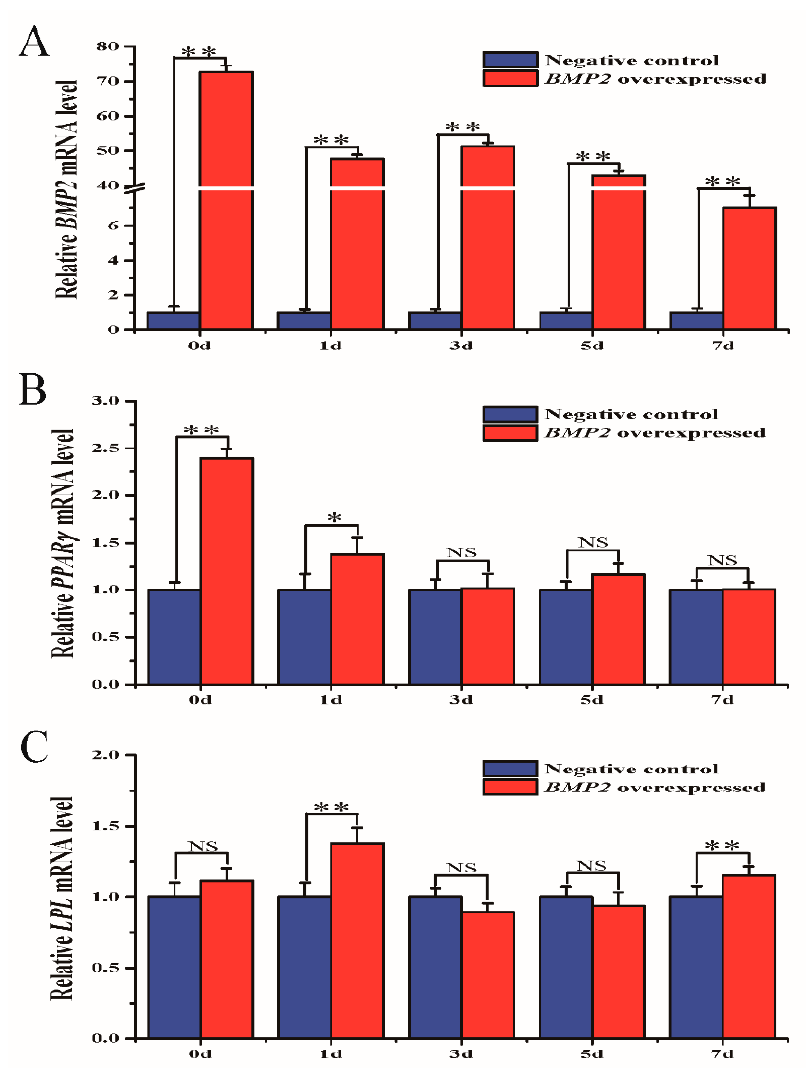
Figure 3. mRNA expression of the PPAR γ and LPL genes. ( A ) mRNA expression of the BMP2 gene. ( B ) mRNA expression of the PPAR γ gene. ( C ) mRNA expression of the LPL gene. * p < 0.05, ** p < 0.01, NS: no significant difference. ACTB was used as a reference gene.